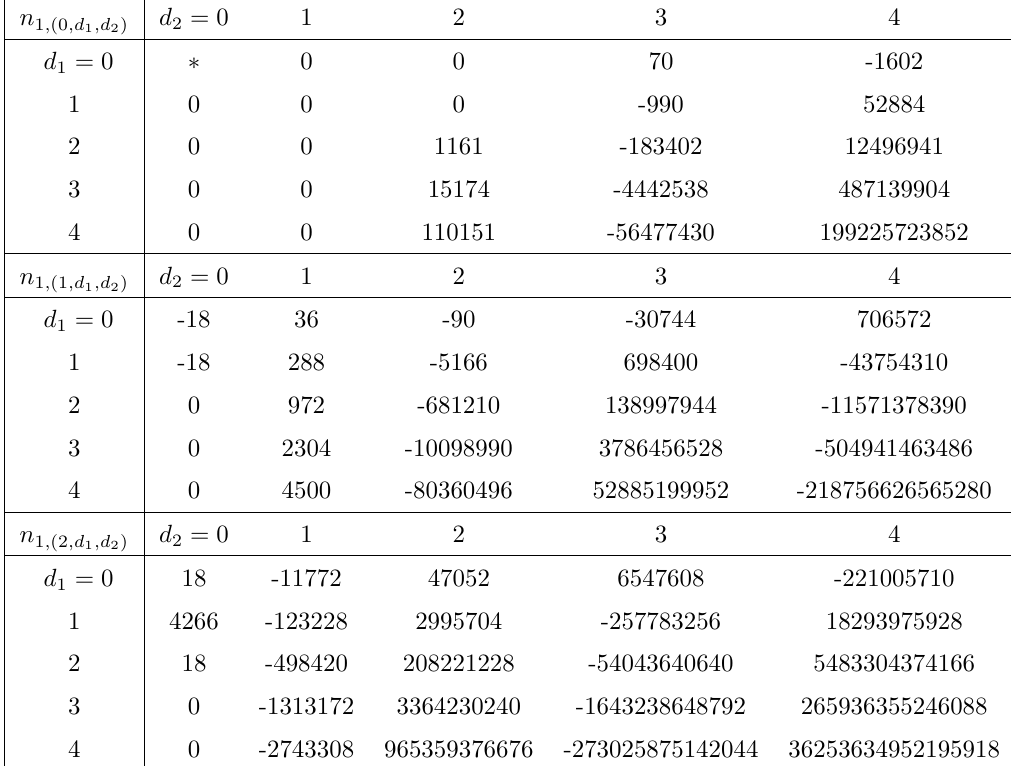
Table 7 . Genus 1 invariants of M E 8 P 1 × P 2 for degree d e = 0 , 1 , 2 of the elliptic parameter.